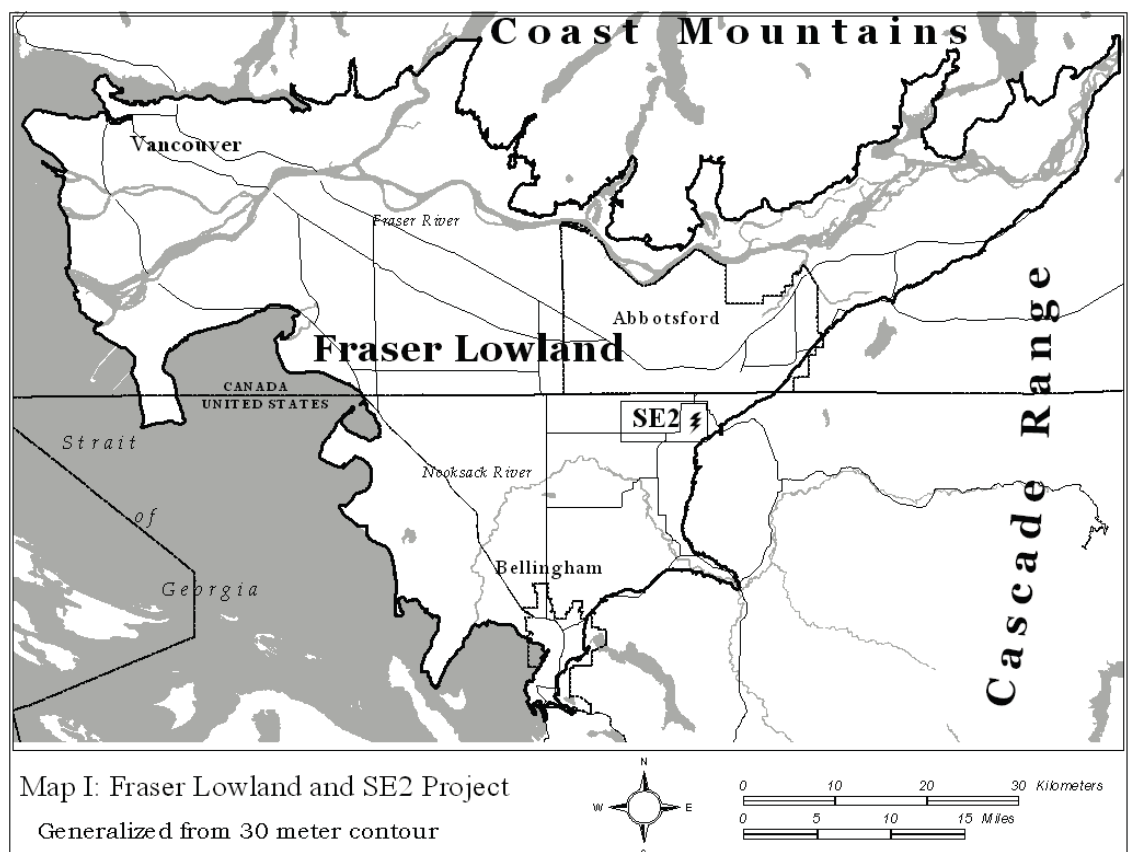
Figure 1. Map of fraser lowland and location of se2